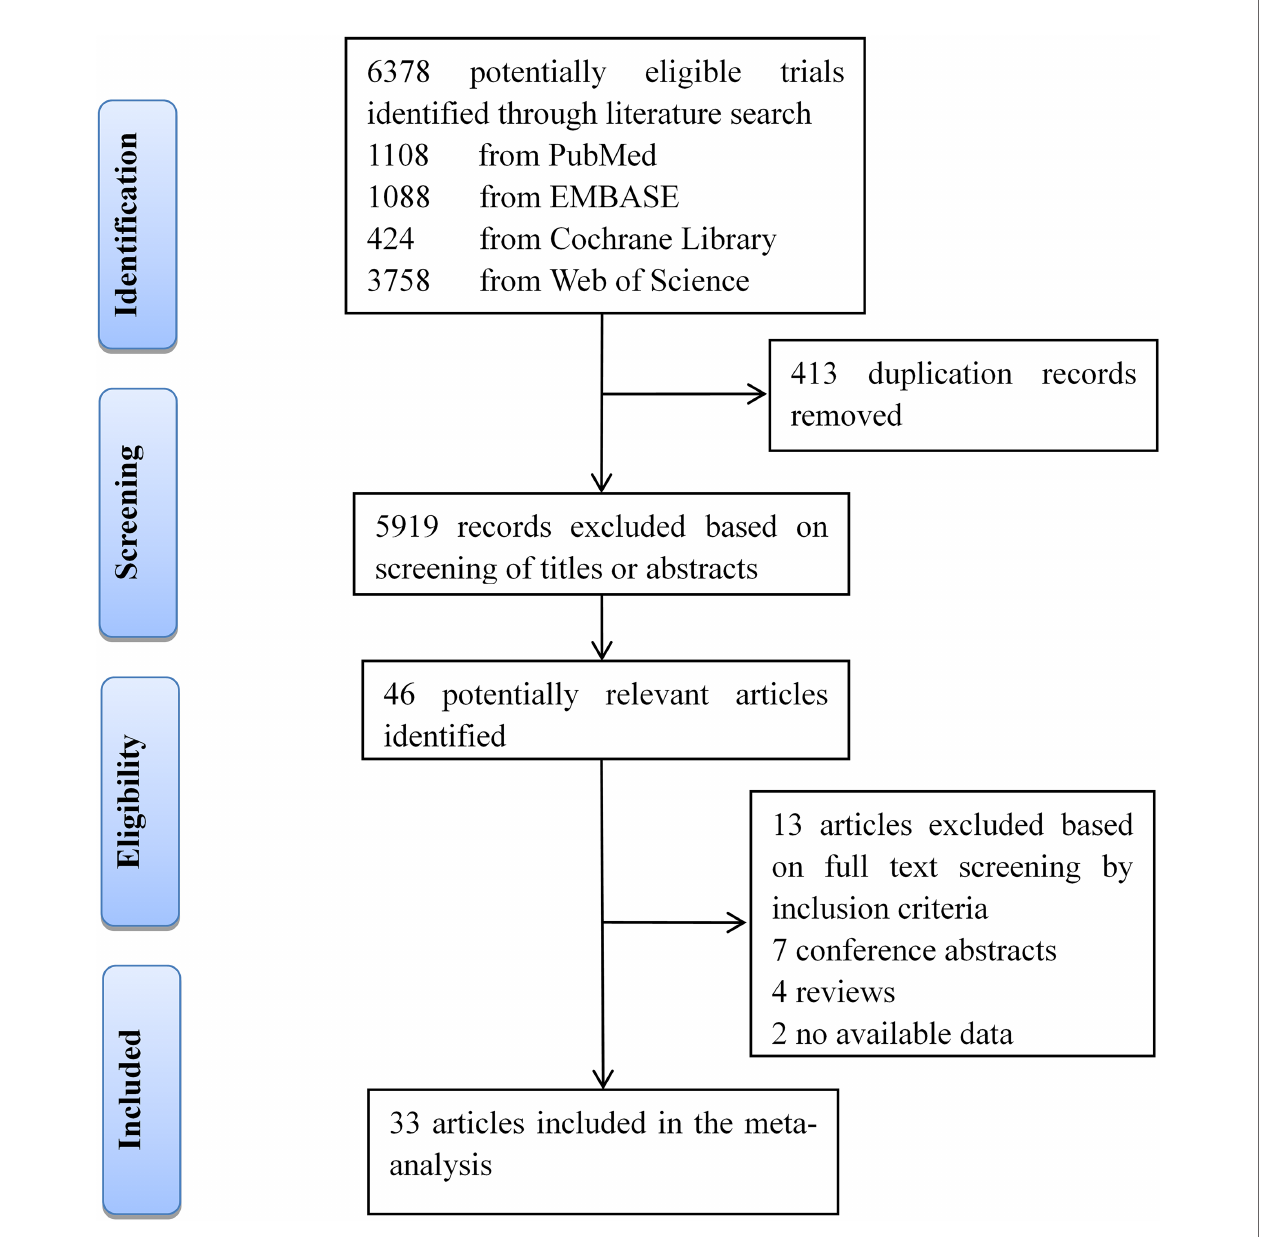
FIGURE 1 | Flow diagram of the literature screening process and